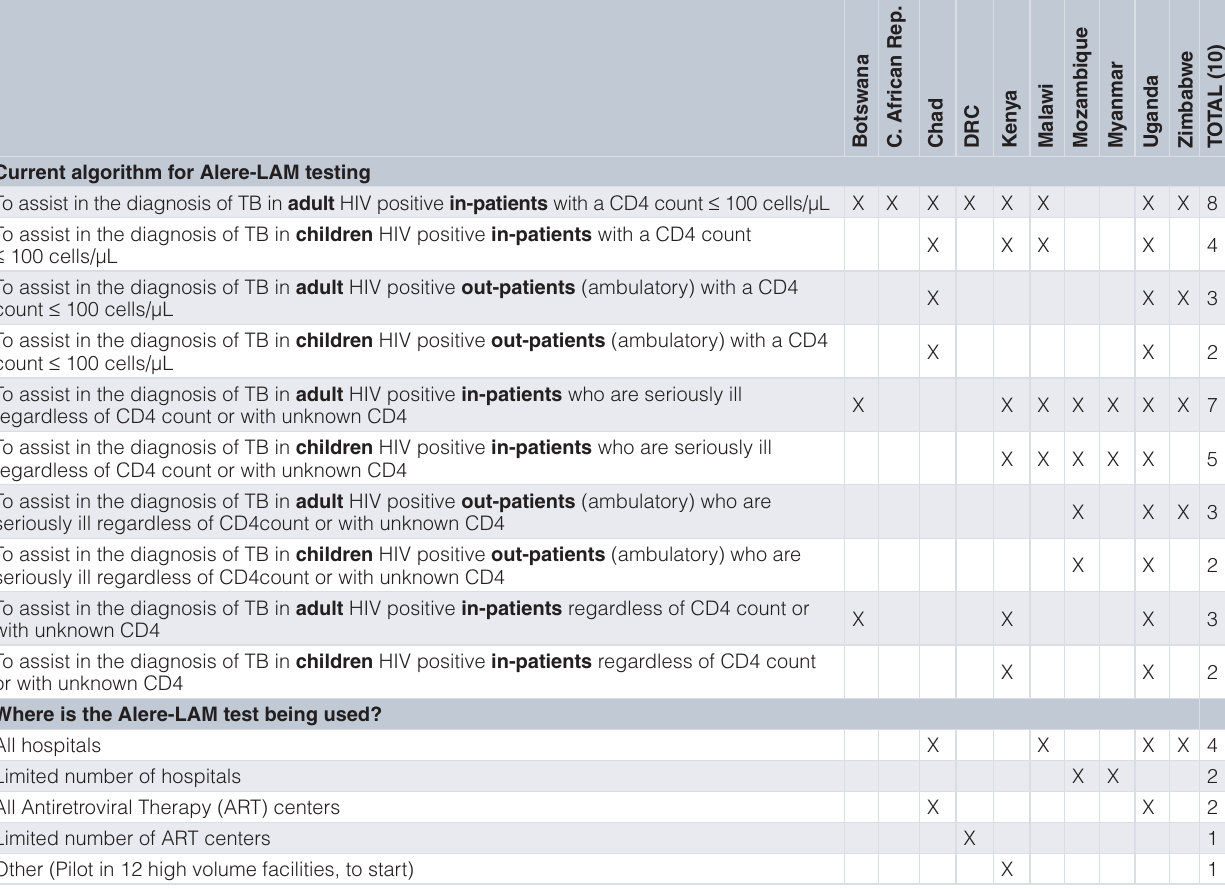
Current algorithm for Alere-LAM